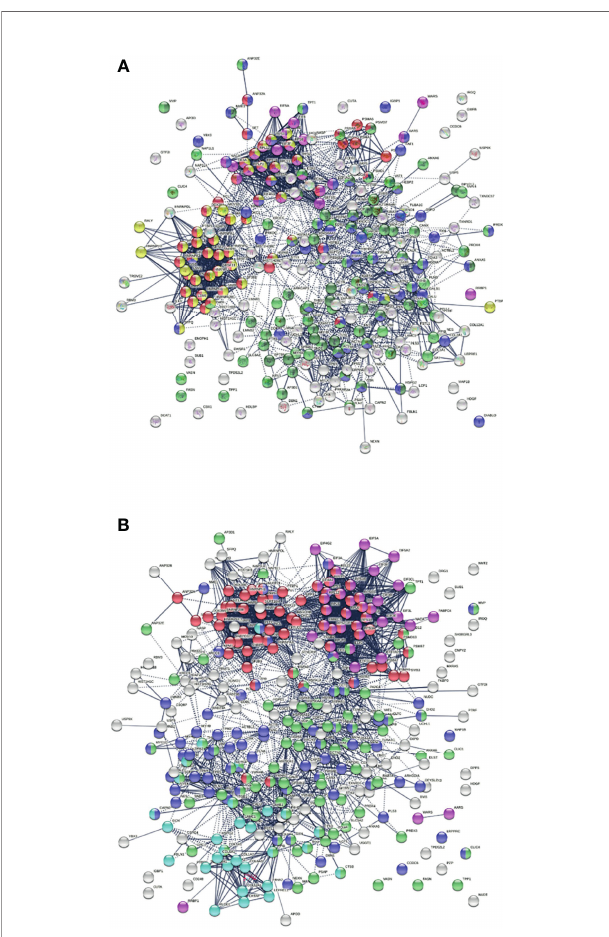
FIGURE 3 | (A) Interaction network of 260 up-regulated proteins in SARS- CoV-2 infected cells or patients. Connecting lines represent interactions with high con fi dence (minimum interaction score of 0.7). Colored proteins are involved in metabolism of RNA (54 proteins, red), translation (28 proteins, pink), vesicles (82 proteins, light green) and vesicle-mediated transport (67 proteins, dark green), regulation of cell death (61 proteins, blue), and mRNA metabolic process (46 proteins, gold). (B) Interaction network of 303 down- regulated proteins in SARS-Cov-2 infected cells and patients. Connecting lines represent interactions with high con fi dence. Marked proteins are involved in RNA metabolism (64 proteins), translation (39 proteins, pink), vesicles (88 proteins, green), cytoskeleton (73 proteins, blue), and extracellular matrix organization (29 proteins,